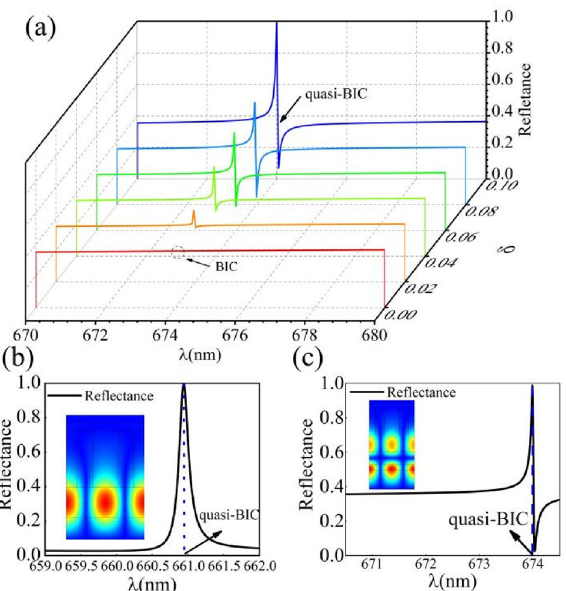
Figure 7. ( a ) The value of reflectance for various values of δ and wavelength. The value of δ is changed from 0 to 0.1 which can explain the appearance of the quasi-BIC. When the δ decreases to 0, the resonance peak disappears gradually, which signifies the appearance of the BIC. ( b ) The reflectance spectra of the grating for wavelengths from 659 to 662 nm. ( c ) A sharp resonance peak appears at the quasi-BIC is shown in the reflectance spectra of the mixed structure; the reflectance is plotted for values of wavelength from 670 to 675